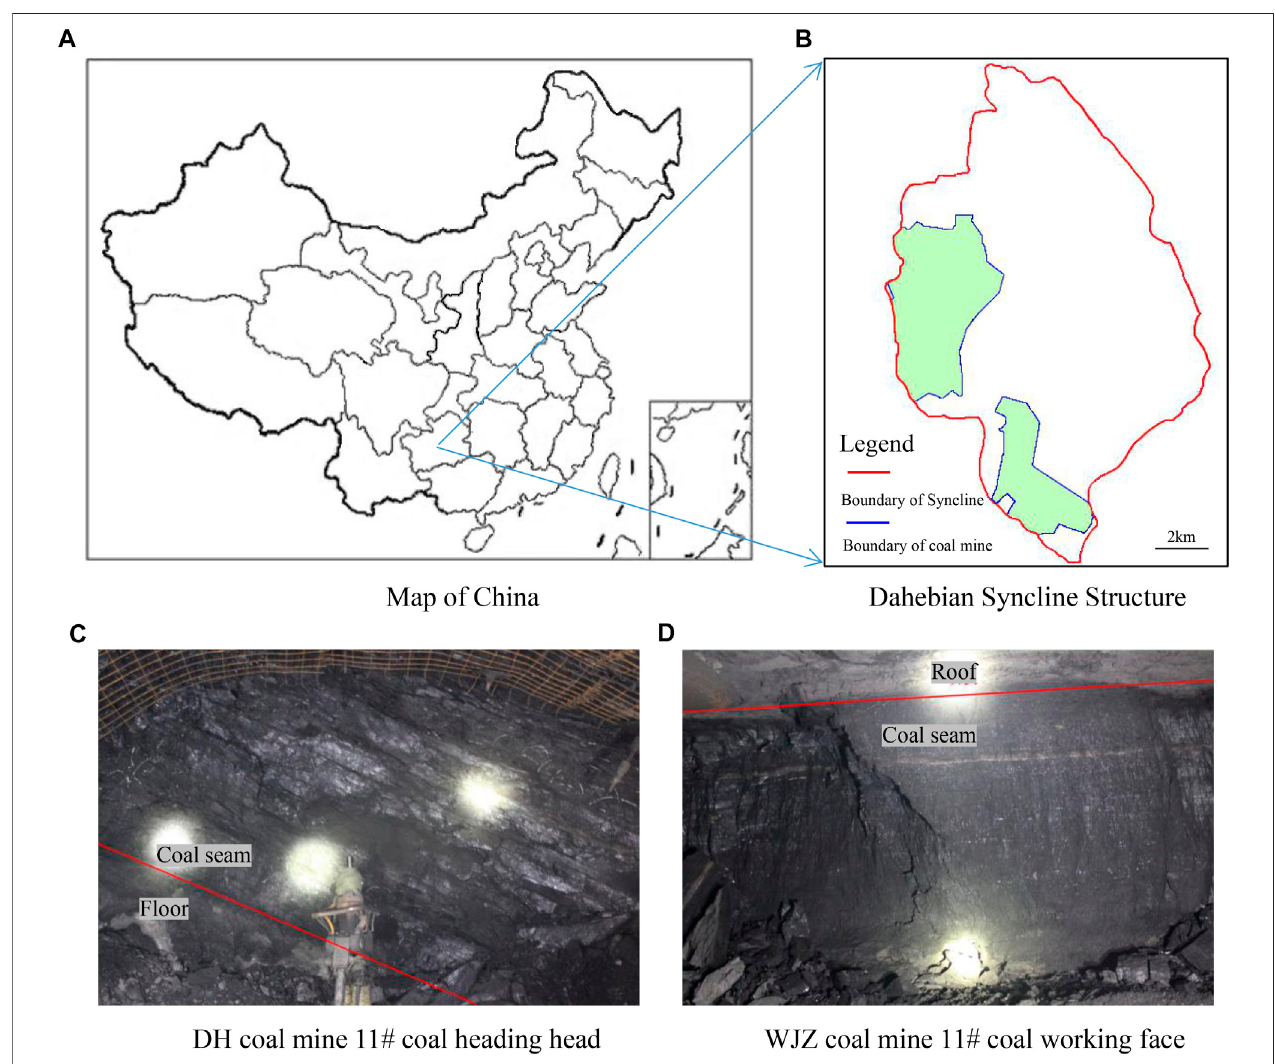
FIGURE 1 | Dahebian syncline structure and the condition of underground coal seam in DH and WJZ regions. (A) Map of China. (B) Dahebian Syncline Structure. (C) DH coal mine 11# coal heading head. (D) WJZ coal mine 11# coal working face.